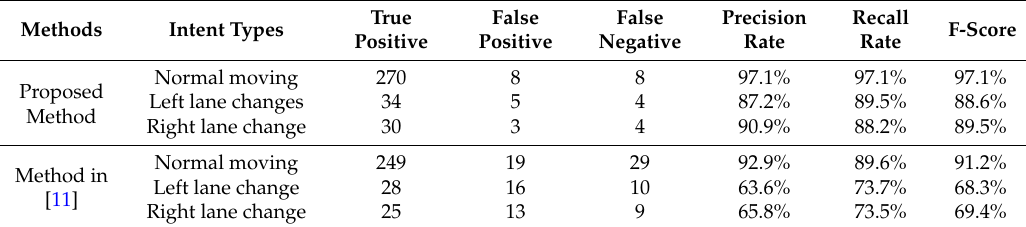
Table 3. Performance on straight roads.